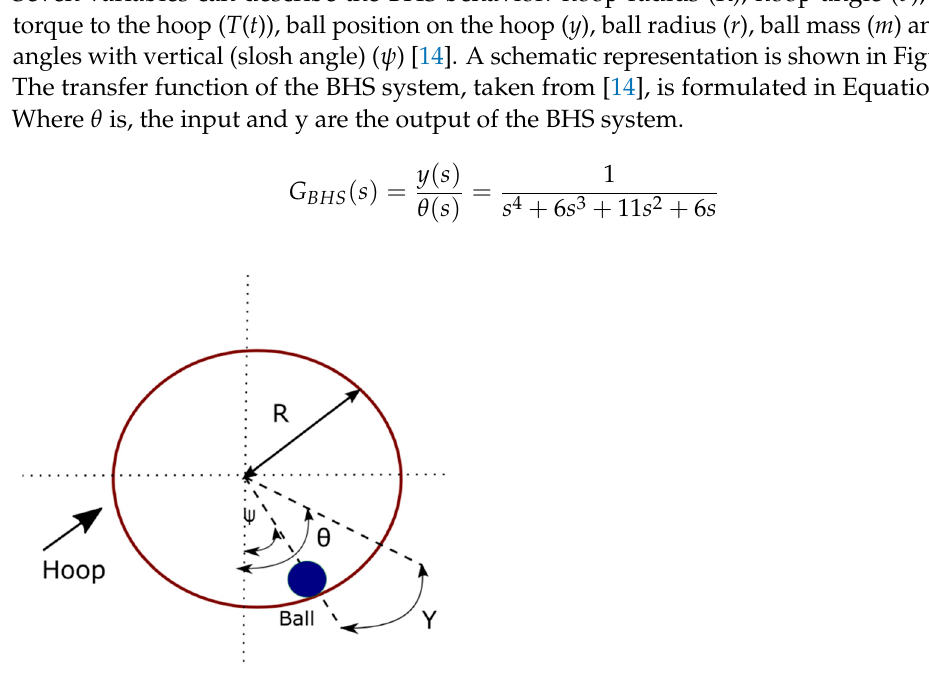
Figure 15. Schema of the ball and hoop system [14].